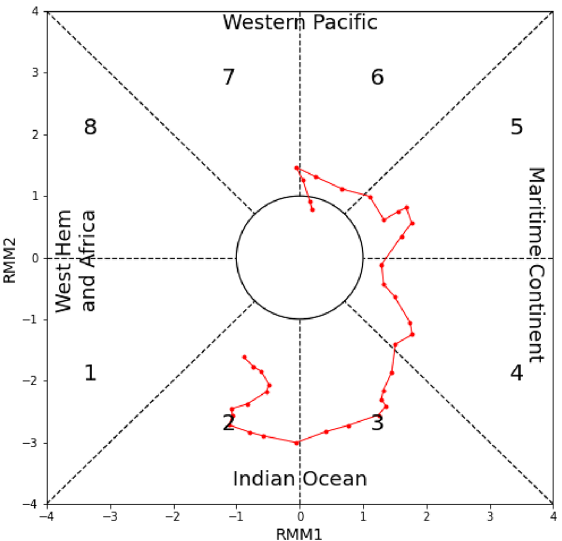
Figure 1. Wheeler–Hendon phase diagram of the MJO event for the period between 3 March and 9 April 1986, for observations. The diagram shows the eight areas of activity of MJO starting from the Indian Ocean.